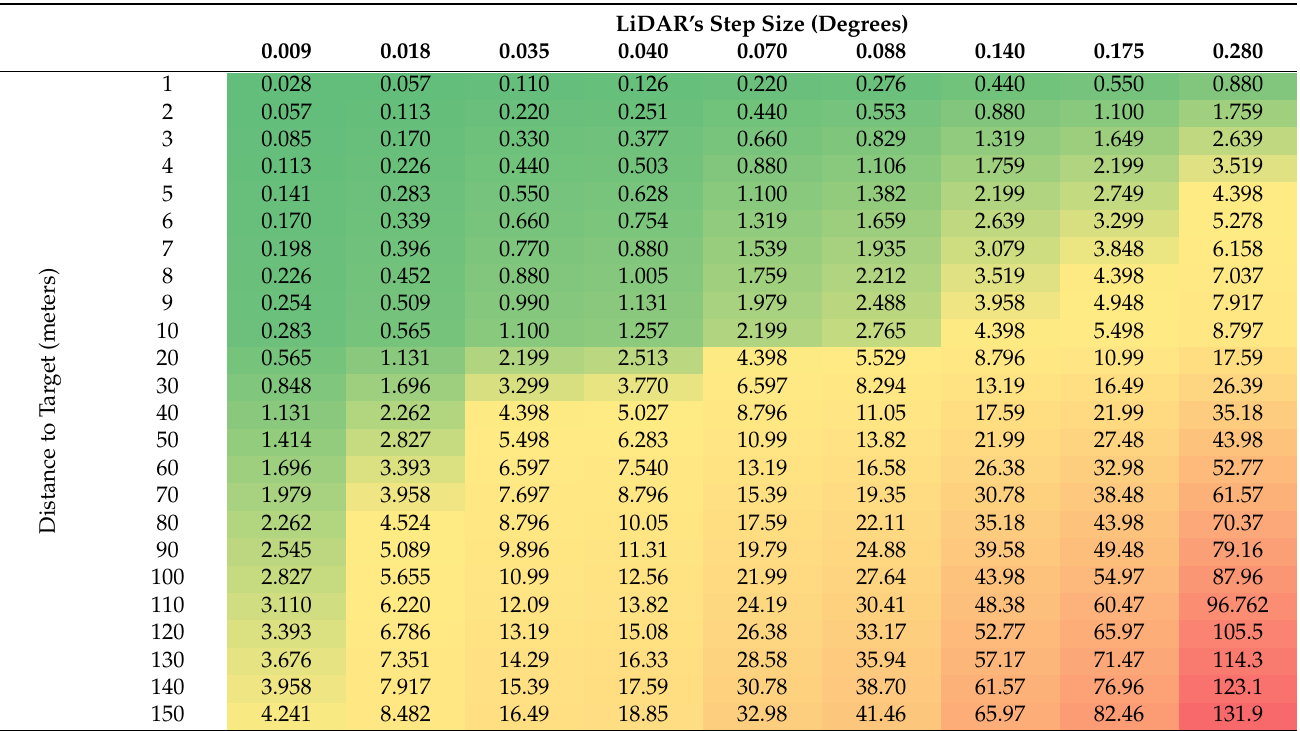
Step 3—Based on the results from Steps 1 and 2, use Table 10 to estimate the amount of time per scan, based on the initial Step Size and Temporal Frequency. Table 8. Minimum Amplitude of Vibration Detected. Local Accuracy (cm).